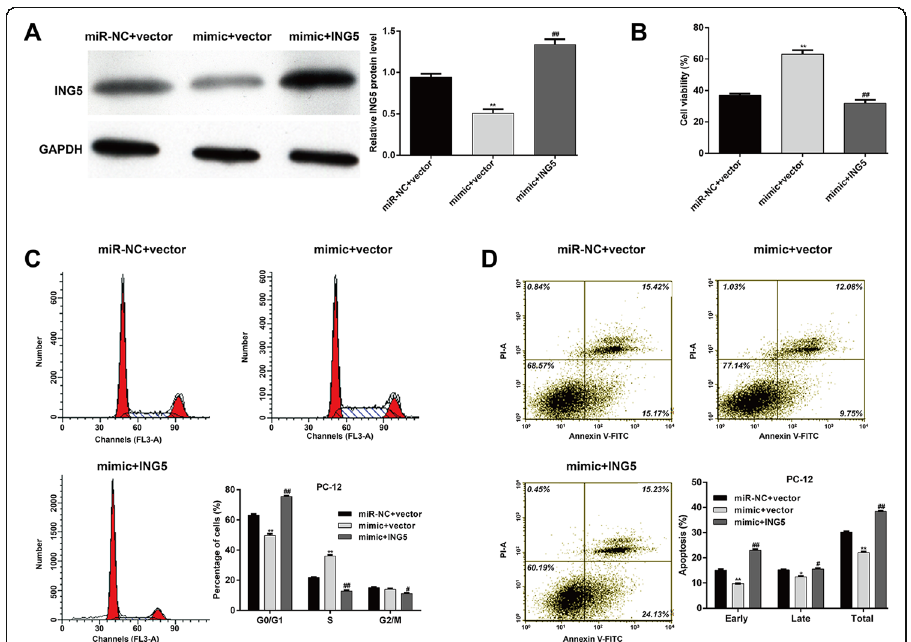
Fig. 5 Restoration of ING5 expression reversed the effect of miR-376c-3p overexpression on OGD-induced cell injury. PC-12 cells were co-transfected with pcDNA3.1/ING5 vector and miR-376c-3p mimic and then subjected to OGD. ( a ) The protein expression of ING5 was detected using western blotting. ( b ) Cell viability was measured using the CCK-8 assay. ( c ) Cell cycle distribution was analyzed using flow cytometry with PI staining. ( d ) Cell apoptosis was examined using flow cytometry with Annexin V/PI double staining. Data are expressed as means ± SD. *p < 0.05, **p < 0.01 vs. miR-NC + vector; # p < 0.05, ## p < 0.01 vs. mimic +